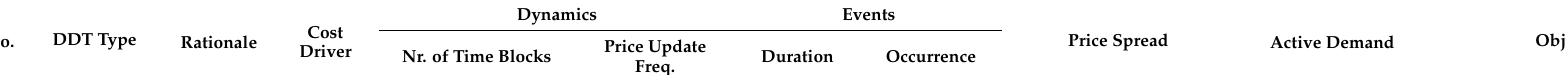
Table 3. Dynamic Distribution Tariffs in